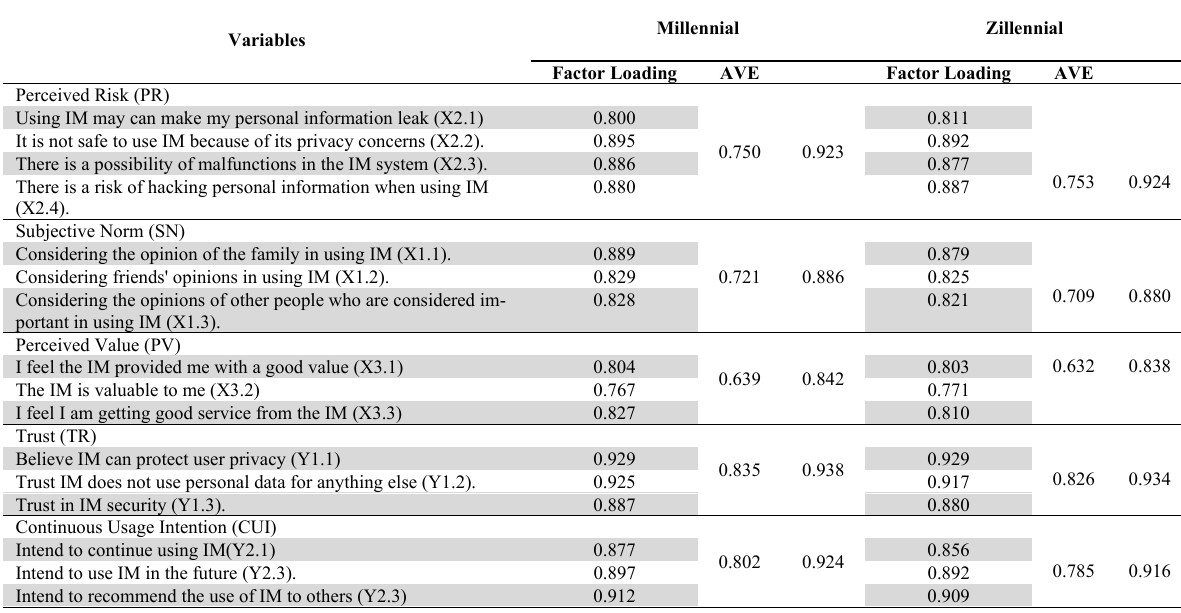
Factor Loading, AVE, CR, ρ A , ρ C and α Values Variables